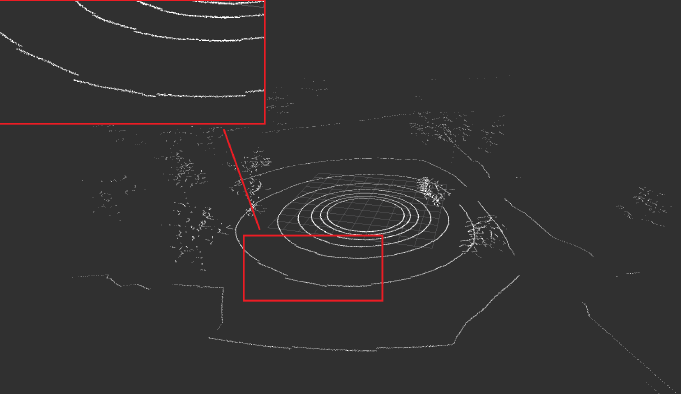
Figure 15. The rolling shutter effect visible on the point cloud obtained from a